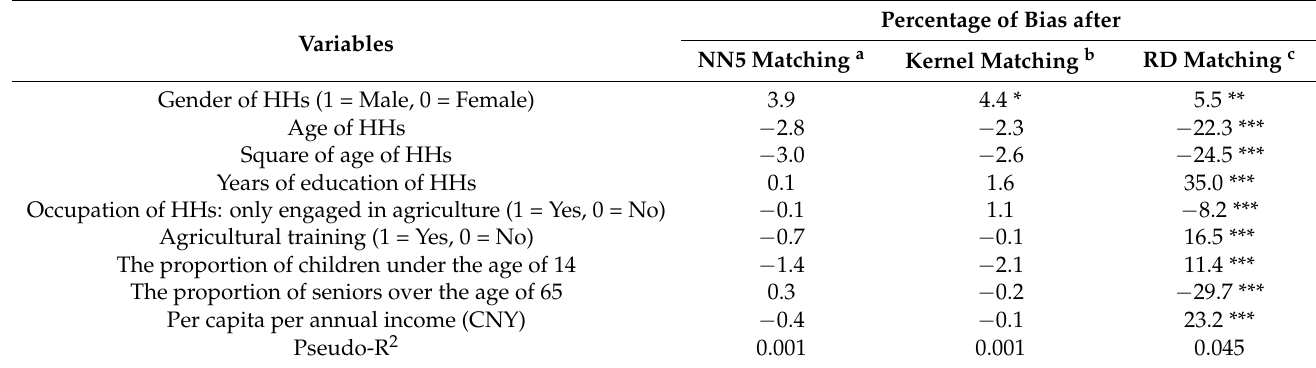
Table 3. The test of matching